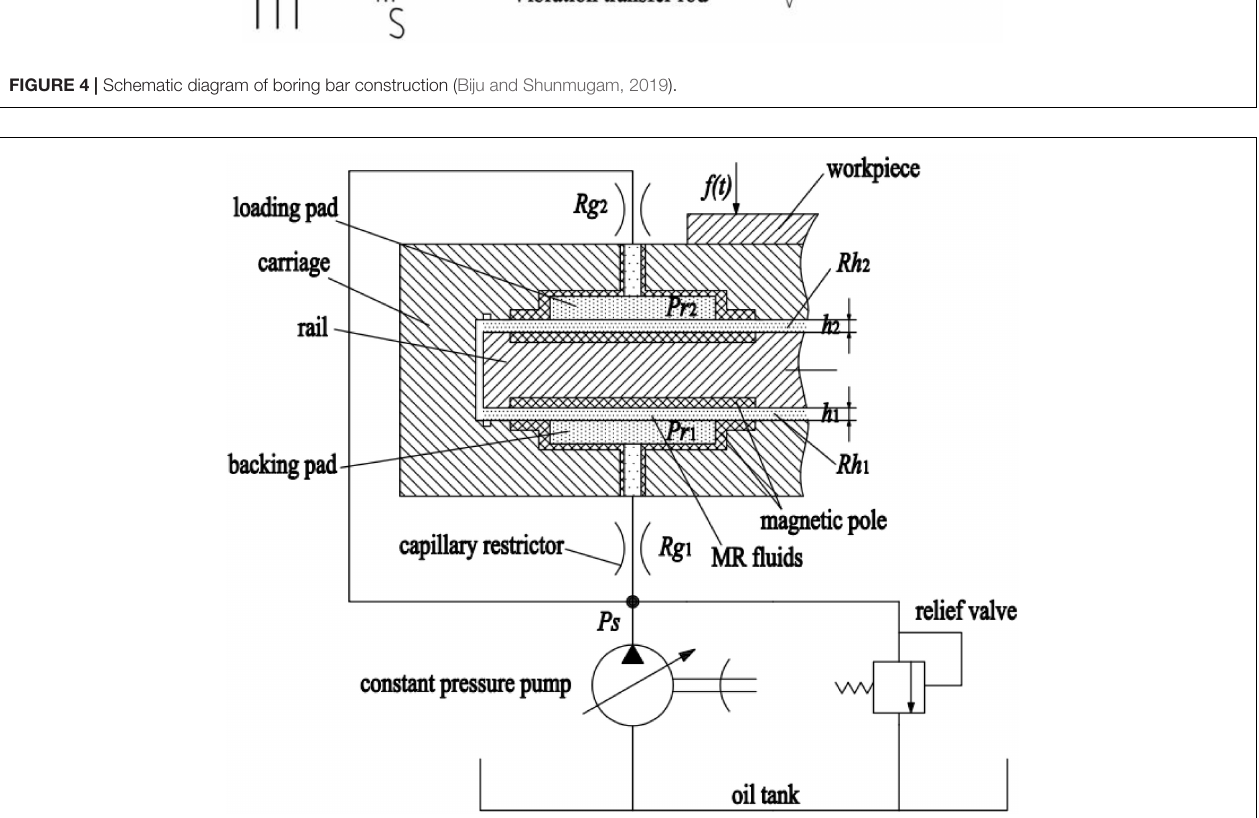
FIGURE 5 | Scheme of MRF hydrostatic guideway system (Liu and Hu,